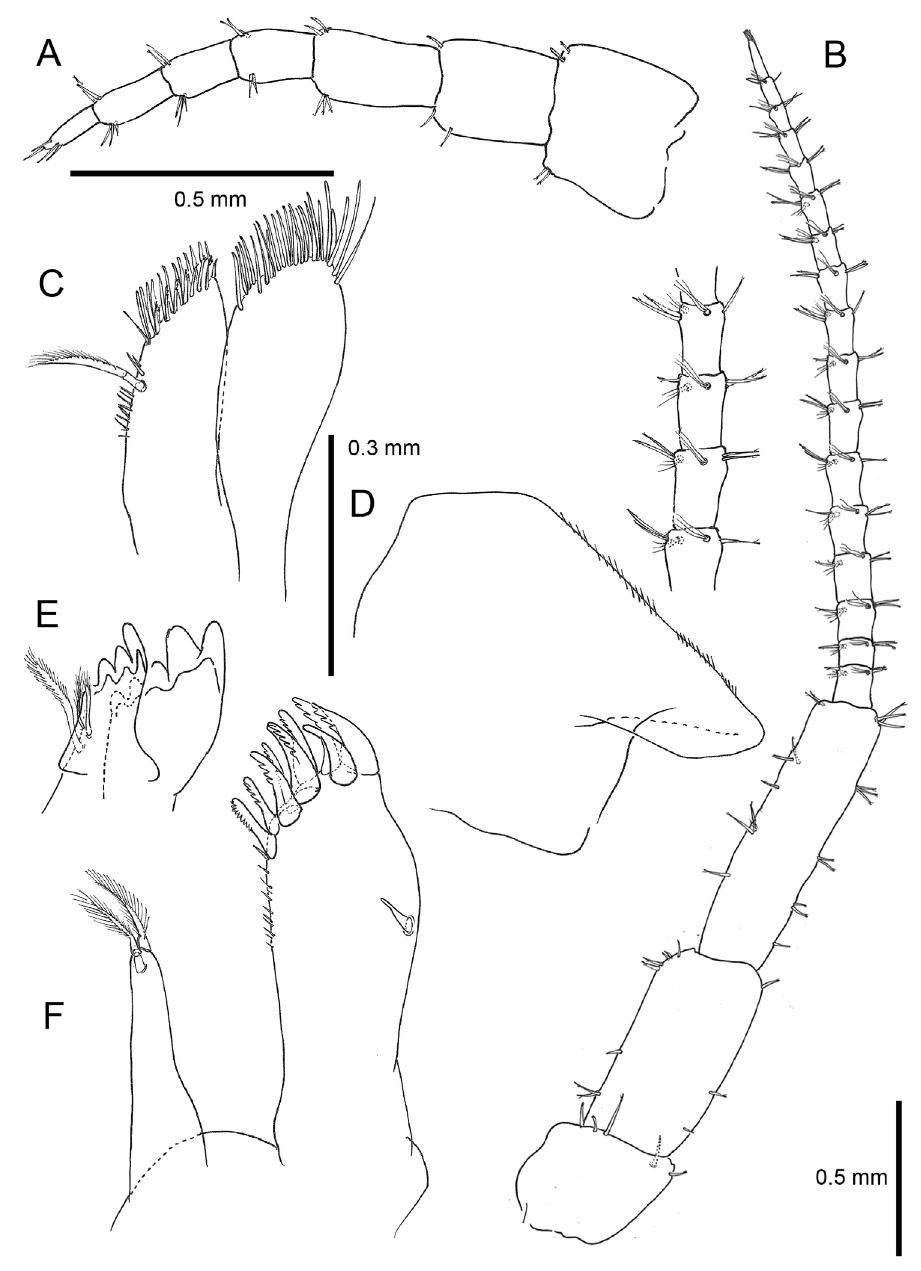
Figure 3. Cryptorchestia ruffoi sp. n., paratype male, 10.4 mm (RMNH) A antenna 1 B antenna 2 C maxilla 2 D lower lip E lacinia mobilis, left mandible F maxilla